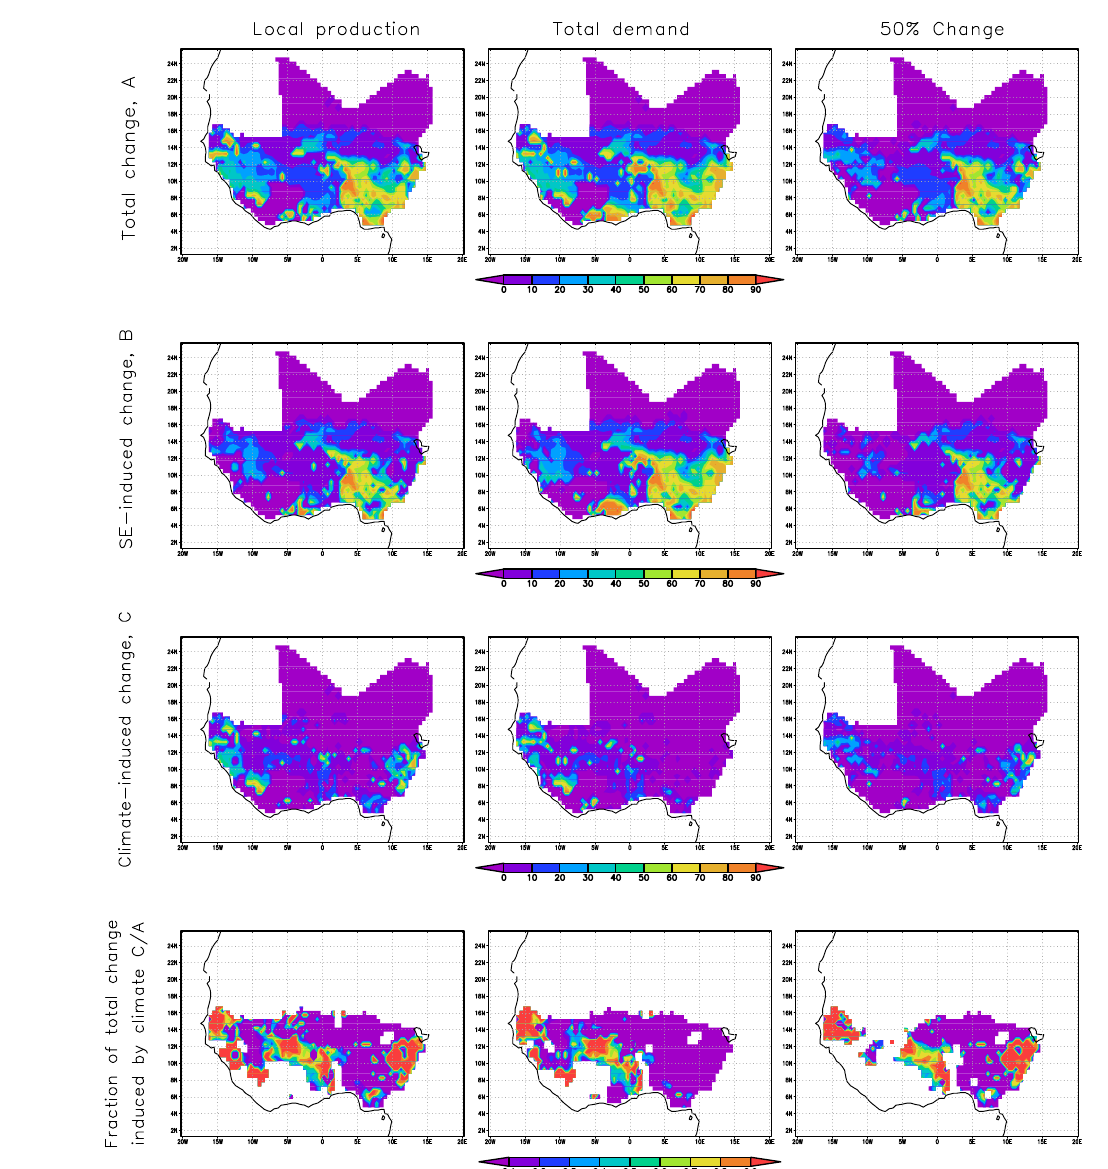
Figure 3. Land use changes projected by LandPro assuming three different levels of future demand, under the MIROC-driven regional climate. First row: absolute magnitude of total land use changes; second row: changes due to socioeconomic factors; third row: changes due to climatic factors; fourth row: climate-induced change as a fraction of total